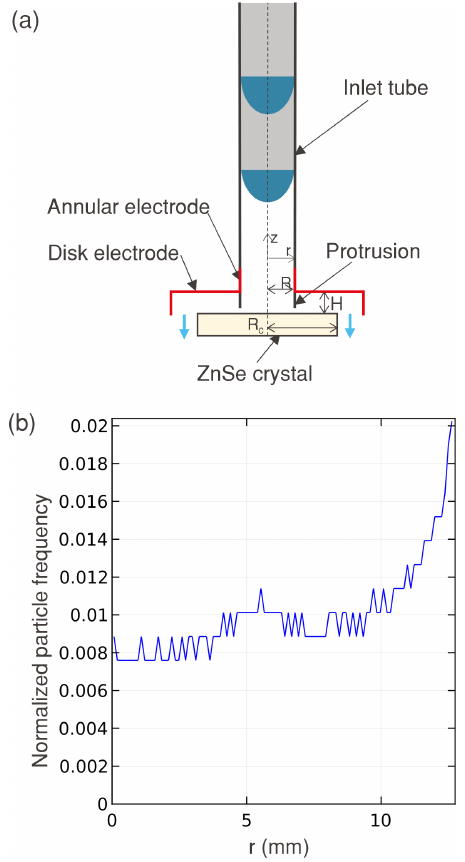
Figure 1. (a) A schematic representation of the radial ESP where particles enter through an inlet tube that is extended closer to the collection crystal through a protrusion. The particles are focused on the crystal using high-voltage electrodes near the exit of the tube, as well as above and around the crystal. (b) Radial particle depo- sition profile as obtained from a COMSOL simulation of velocity, electrostatics, and particle tracing on the device in (a) – the mound of particles near r = 5mm corresponds to the position of the protru-